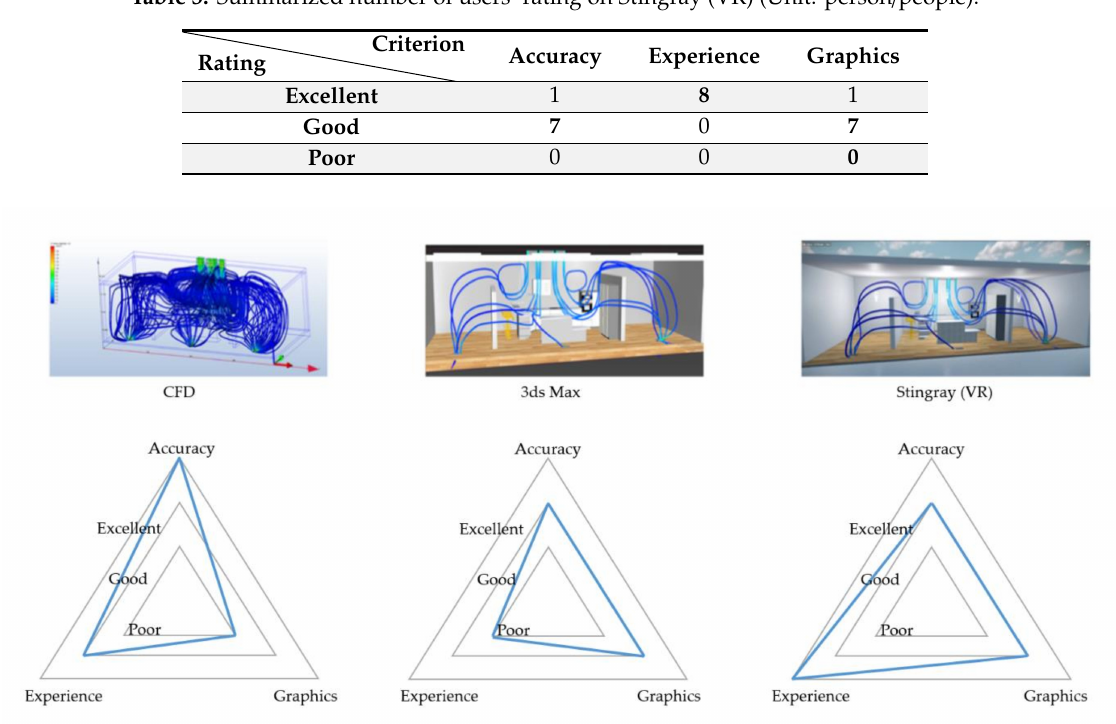
Figure 17. Rating of visualization results in Autodesk CFD, Autodesk 3ds Max, and Autodesk